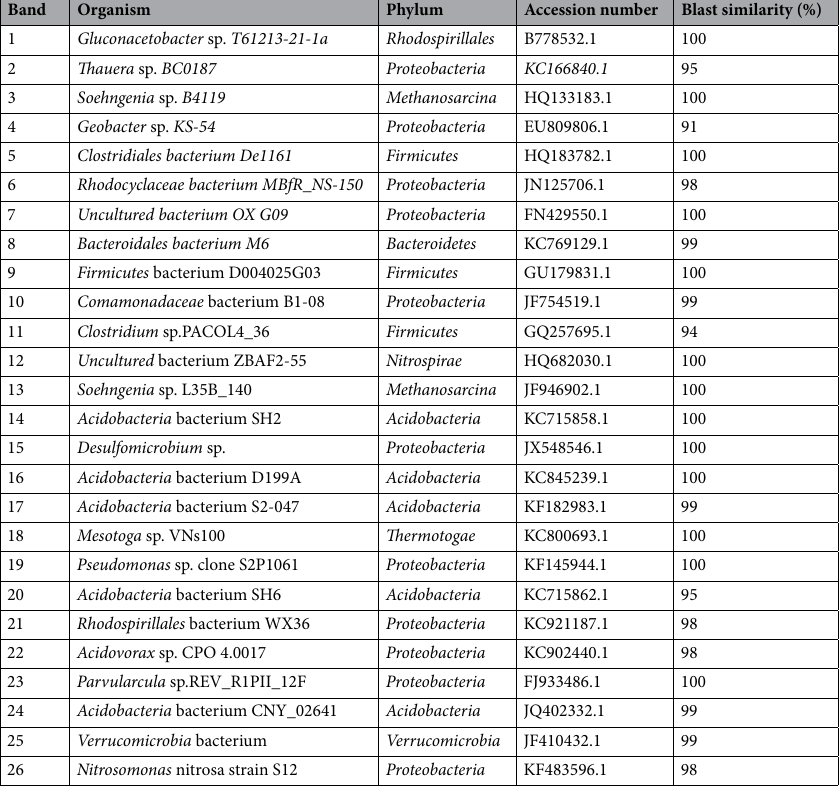
Table 4. Phylogenetic sequence affiliation of amplified 16S rDNA sequence excised from DGGE of the biochemical units.